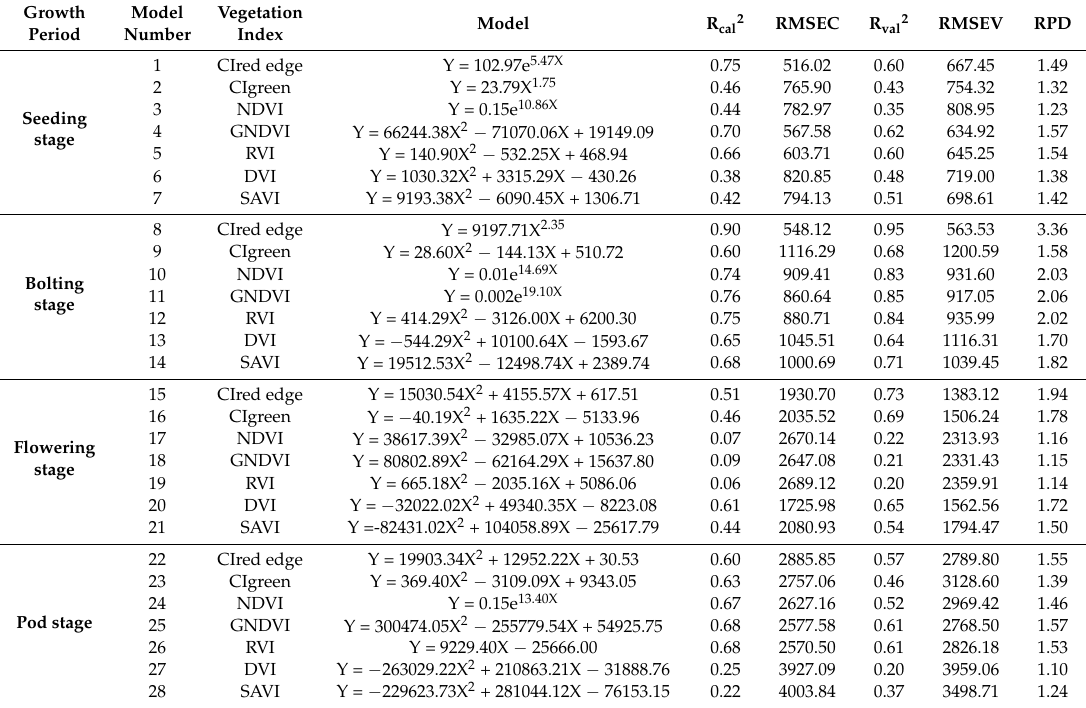
Table 5. Regression modeling analysis between the seven VIs and